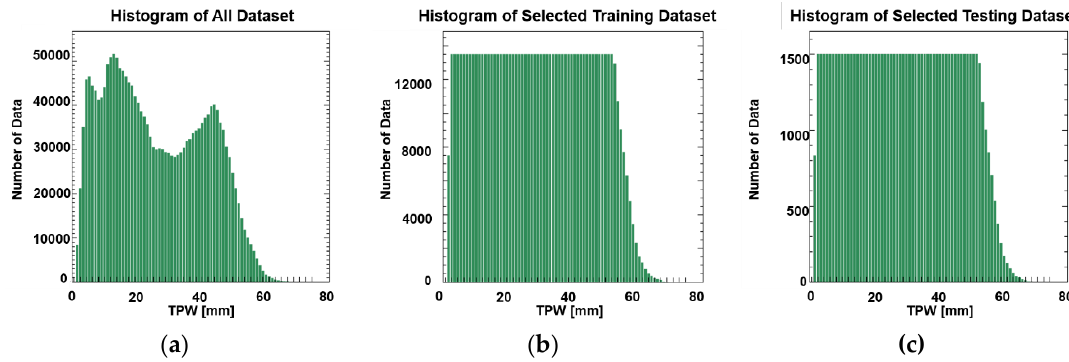
Figure 3. Histograms of training data for machine learning in Northeast Asia for two years (i.e., September 2016 to August 2018). The x-axis is the TPW range (0–80 mm) and the y-axis is histogram density. The bin size is 1 mm. ( a ) Histogram of all TPW during the period, ( b ) histogram of the selected TPW (13,500 datasets per bin size) for training, and ( c ) histogram of the selected TPW (1500 datasets per bin size) for testing.